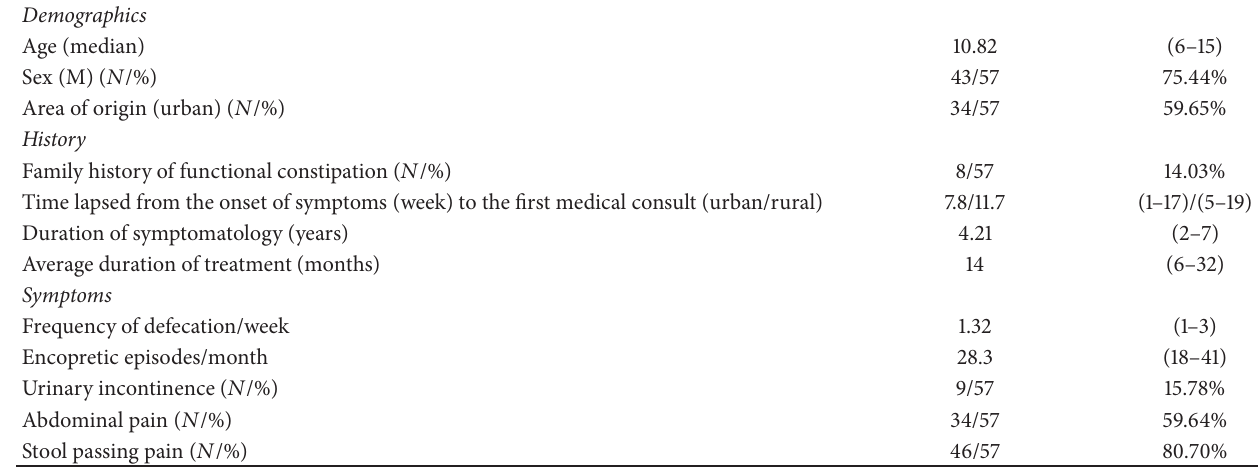
Table 1: Demographic characteristics, history, and clinical features of the patient